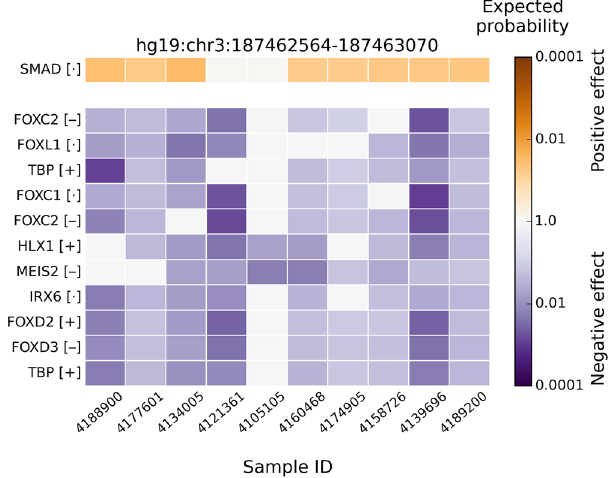
Figure 4. TFs significantly affected at BCL6 patient-specific regulatory mutation block. The row labels are the TF names, and the column labels are patients with the regulatory mutation block near the BCL6 TSS. TF names are repeating when several alternative PWMs for a single TF are significantly affected. The color encodes the expected probability that the TF will be affected by random mutations as strongly as by the patient mutations, on the logarithmic scale. The positive and negative affinity changes are colored orange and blue, respectively. In square brackets inside row labels: “ + ” means that the TF is highly expressed in patient samples (top 25%), “ • ” means average expression, “ − ” means low expression (lower 25%). TFs with very low expression (RPKM < 0.03) were filtered out. Only TFs with significant changes (P < 0.05 after Bonferroni correction) across all patients are